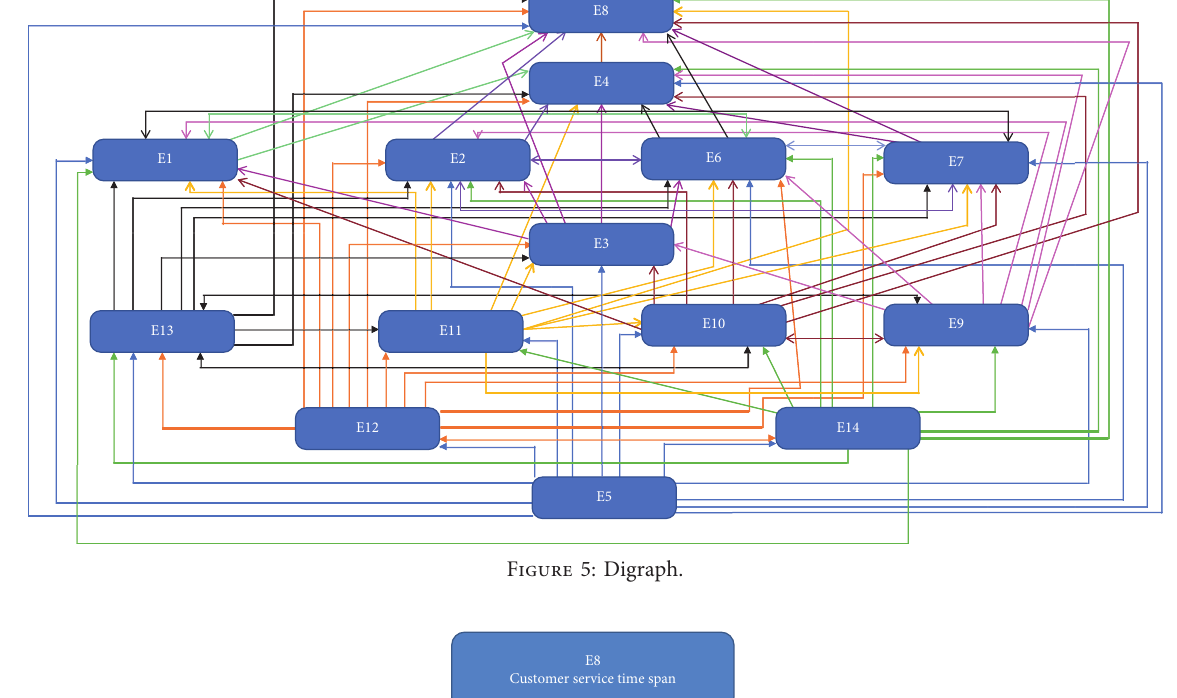
Figure 5: Digraph.